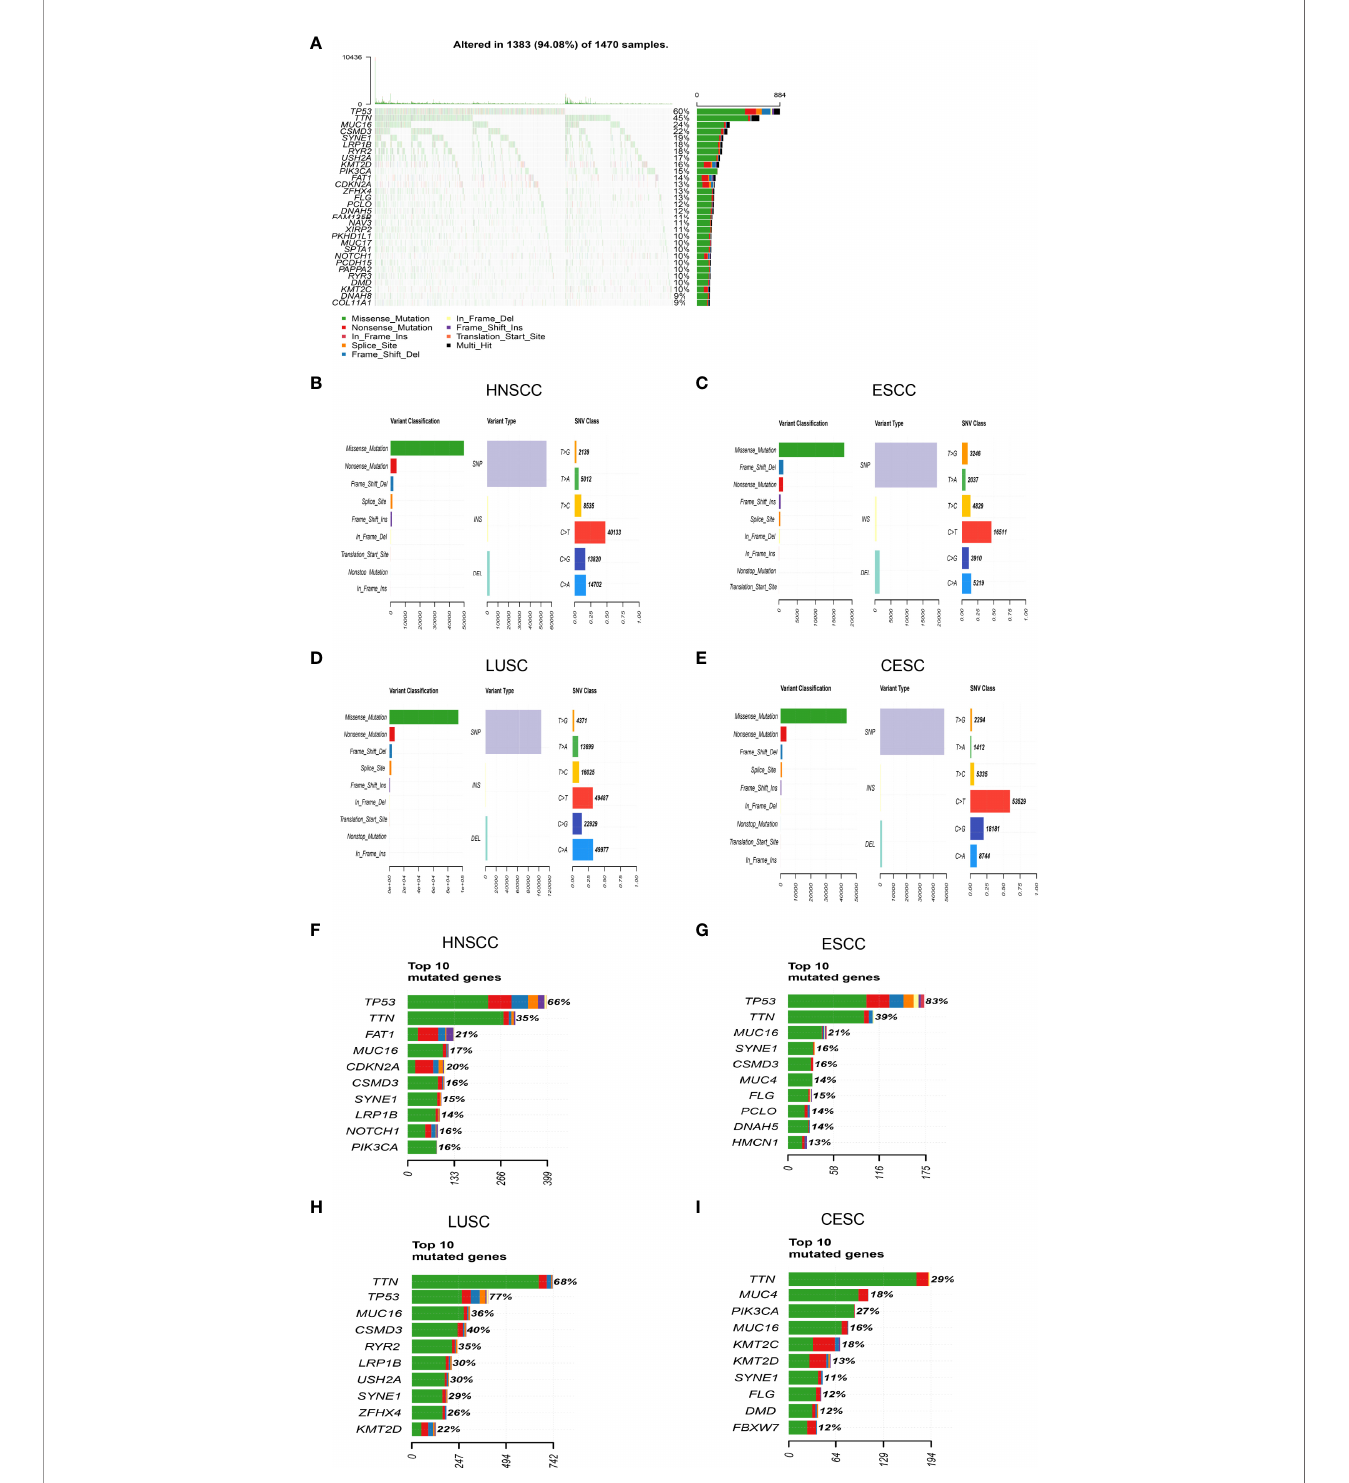
FIGURE 1 | Summary of mutational landscape in SCC patients from TCGA database (A) Mutation information in each SCC sample was shown in the waterfall plot, in which various colors representing different mutation types were annotated at the bottom. (B – E) Missense mutation was the most common variant classi fi cation, and SNP was the most dominant mutation type in SCC. The C > T transition was the most frequent SNV in HNSCC, ESCC and CESC. The transition of C>A was more common in LUSC. (F – I) The top10 mutated genes were displayed respectively in different